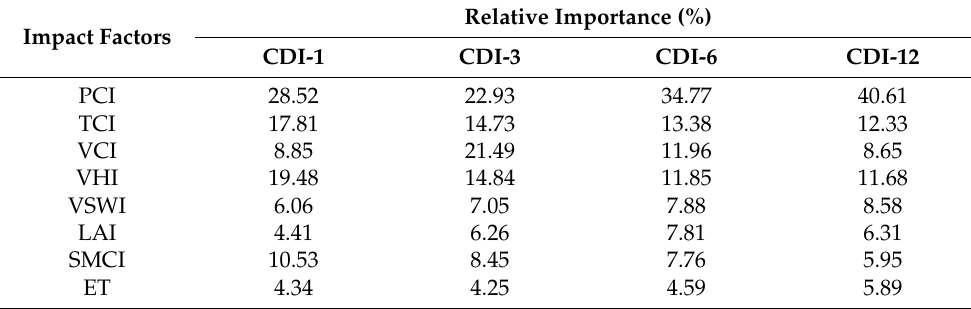
Table 10. Relative importance of factors for drought